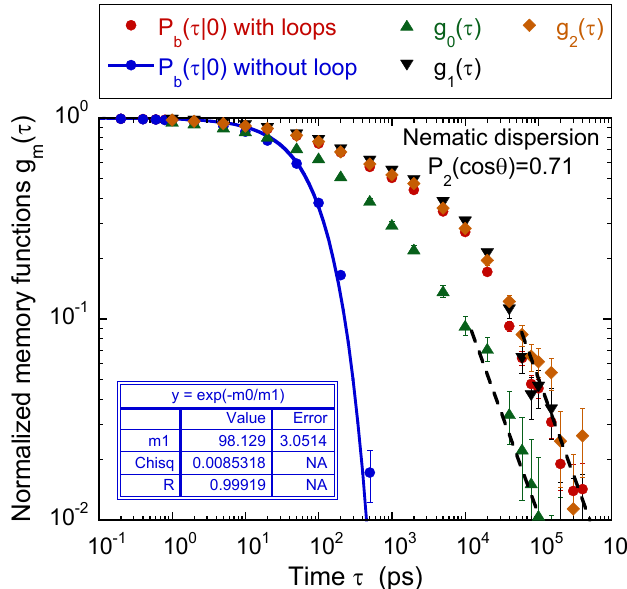
Figure 14. Numerical modeling of the memory function quantifying the decorrelation of the quadrupolar coupling felt by Li + counterions diffusing within a dense sediment resulting from the collection of partially oriented laponite platelets. Reprinted with permission from Ref.